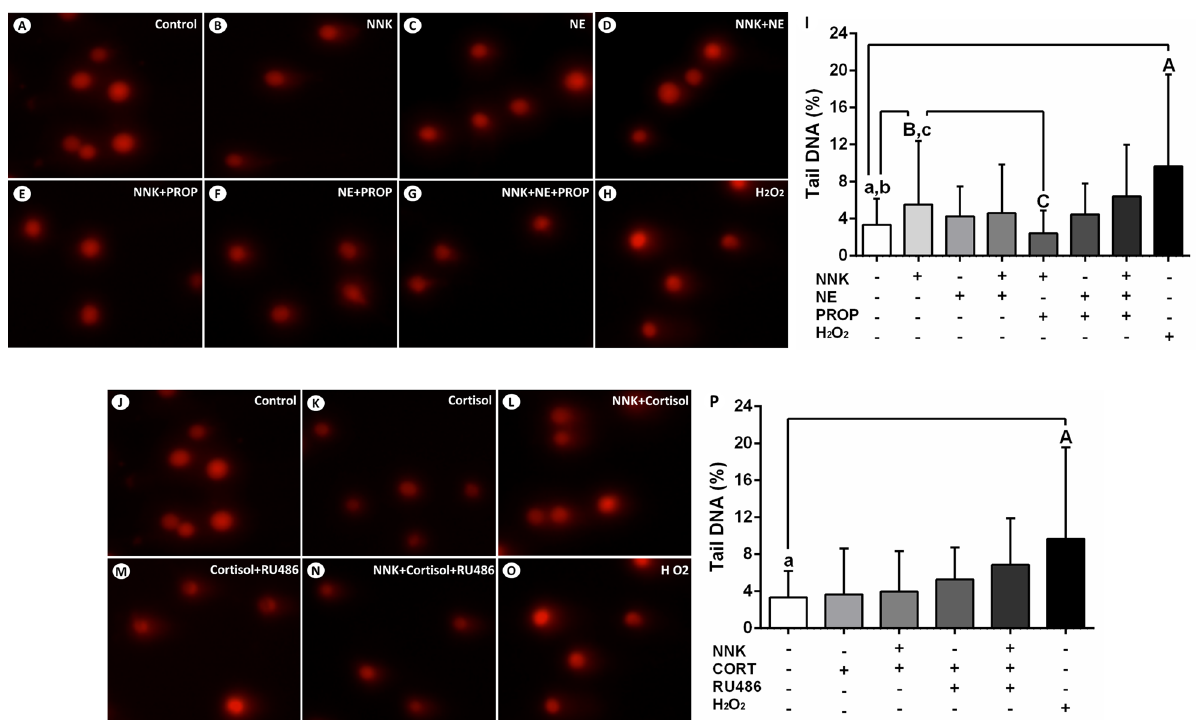
Figure 5. NNK promotes the oxidation of basis in the DNA of NOK-SI cells. ( A ) Control. ( B ) NNK. ( C ) Norepinephrine. ( D ) NNK and norepinephrine. ( E ) NNK and propranolol. ( F ) Norepinephrine and propranolol. ( G ) NNK, norepinephrine and propranolol. ( H ) H 2 O 2 (positive control). ( I ) Cells treated with H 2 O 2 or NNK exhibited an increase in the DNA damage, when compared to untreated cells after exposure to FPG enzyme. Beta-adrenergic antagonist propranolol blocked this effect. Norepinephrine in the presence or absence of NNK did not induce significant oxidation of basis. Cortisol did not promote significant oxidative DNA damage. ( J ) Control. ( K ) Cortisol. ( L ) NNK and cortisol. ( M ) Cortisol e RU486. ( N ) NNK, cortisol and RU486. ( O ) H 2 O 2 (positive control). ( P ) H 2 O 2 promoted DNA damage in oral keratinocytes. Cells treated with cortisol alone or combined with NNK did not show significant changes regarding the oxidation of basis. The results are expressed as the mean ± standard deviation (SD). Upper- and lower cases equal letters indicate a statistically significant difference ( p < 0.0001). H 2 O 2 = hydrogen peroxide. NNK = 4 (N-metil-N-nitrosamine)- 1-(3-piridil)-butano-1-one). NE = norepinephrine. PRO p = propranolol. CORT = cortisol. NNK, NE, PROP and RU486 were used at 10 µM. CORT was used at 100 nM. NOK-SI cells were exposed to NNK and/or stress hormones in the presence or absence of their antagonists for 72 h.